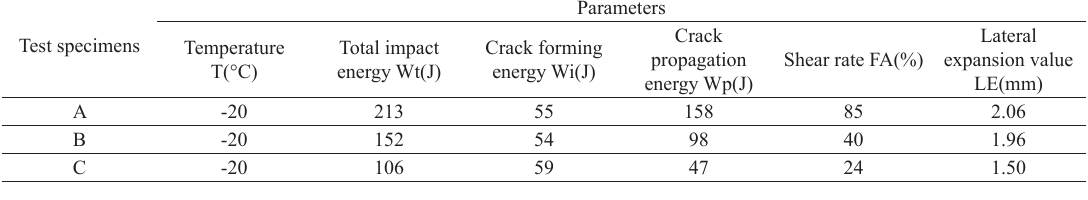
Table 3. The process parameters of welding thermal simulation.